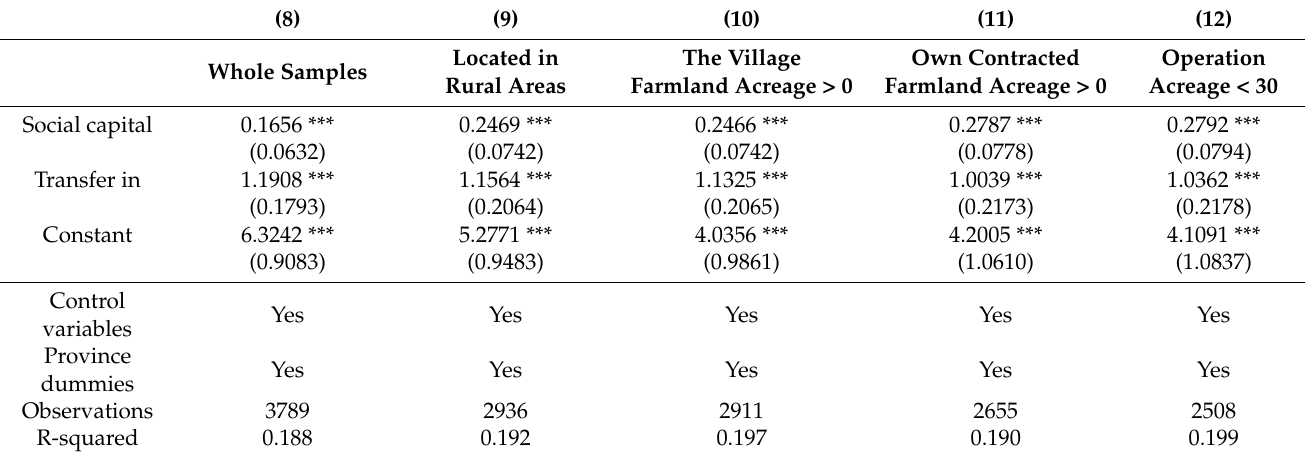
Table 3. Robustness